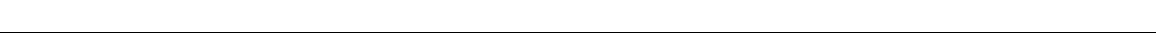
Fig. 1 H2AX loss leads to impaired motor balance and general locomotor activity. a Rotarod tests reveal reduced motor coordination in H2AX knockout mice. Testing was conducted over 3 days with 2 days of training trials. Each mouse was then given three to four trials and latency to fall off the rotarod was measured as it accelerated from 4 to 40 rpm over a 5 min period; y -axis, the latency to fall off in seconds, x -axis, number of trials. Each trial value relates to the average of the latency to fall off (in sec) for the total number of animals used per genotype. Statistical signi fi cance was determined by a two-tailed, unpaired Student ’ s t -test; n = 7 (means ± s.e.m.) for H2AX wild type, n = 8 (means ± s.e.m.) for H2AX knockout; * P < 0.05, ns non-signi fi cant ( P = 0.8570). Left panel represents data for 8-week-old mice; right panel summarizes data for 5-month-old mice. b Open- fi eld testing demonstrated that wild- type mice were signi fi cantly more active than H2AX knockout mice as measured by horizontal activity; y -axis, beam breaks, x -axis, 3 min intervals. Left panel represents data for 8-week-old mice; right panel summarizes data for 5-month-old mice. Statistical signi fi cance was determined by a two-tailed, unpaired Student ’ s t -test; n = 7 (means ± s.e.m.) for H2AX wild type, n = 8 (means ± s.e.m.) for H2AX knockout; *** P < 0.0001, ns non-signi fi cant ( P